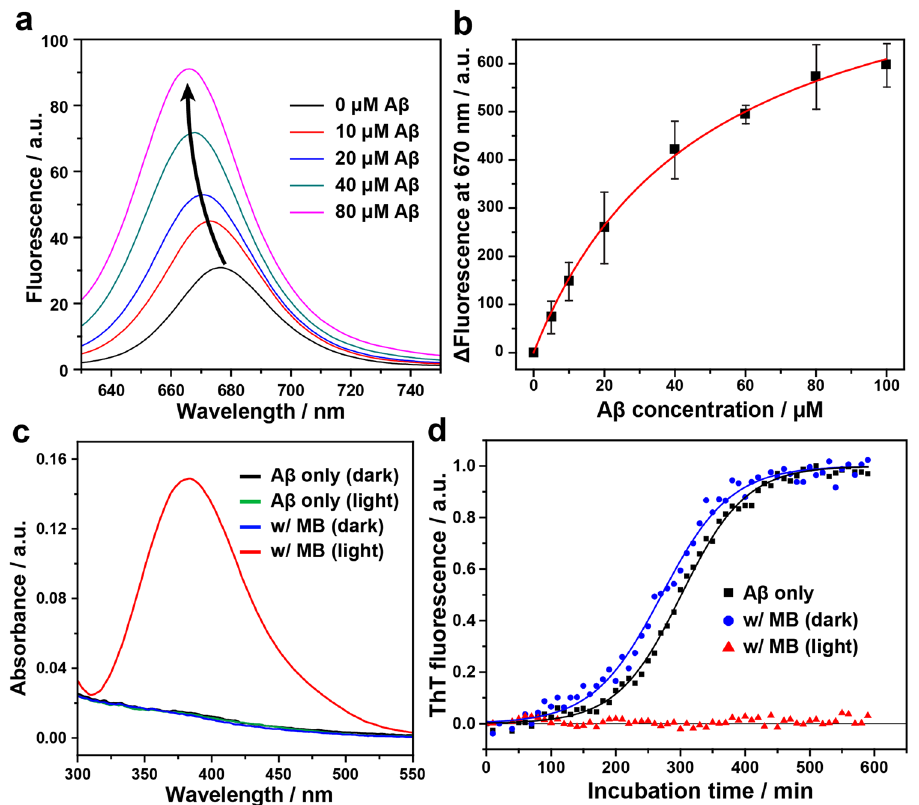
Figure 6. Photo-excited MB inhibits the A β 42 aggregation by means of the binding affinity of MB and the photo-oxidation of A β 42 . ( a ) Change in fluorescence spectra of 0.2 μ M MB upon addition of various concentrations of the A β 42 monomer. ( b ) Fluorescence binding affinity assay between A β 42 and MB. The fluorescence of MB (0.2 μ M) at 670 nm was measured with increasing concentration of A β 42 from 0 to 100 μ M. Binding constant K d was derived from the fitted curve. ( c ) DNPH assay to monitor a carbonyl content in the A β 42 peptide. DNPH reacts with the carbonyl groups in oxidized peptides, resulting in the formation of a DNP hydrazone product, which shows an absorption maximum of near 380 nm. ( d ) The kinetics of A β 42 fibril formation monitored at 30 °C by ThT fluorescence in the absence and presence of MB under dark or light conditions. For the light condition, the MB-treated A β 42 samples were irradiated with LED light for 30 min at 4 °C before the measurement. Each point is an average of the fluorescence signal of at least four wells containing the same solutions. Lines indicate fits of a sigmoidal growth